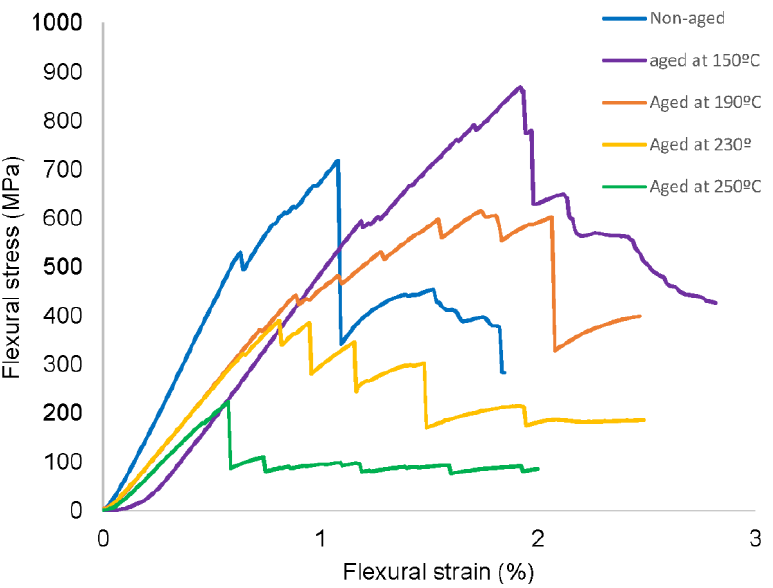
Figure 10. Flexural stress-strain curves of quasi-isotropic [0/90/ ± 45] 2s laminates aged at different temperatures for 10 days.